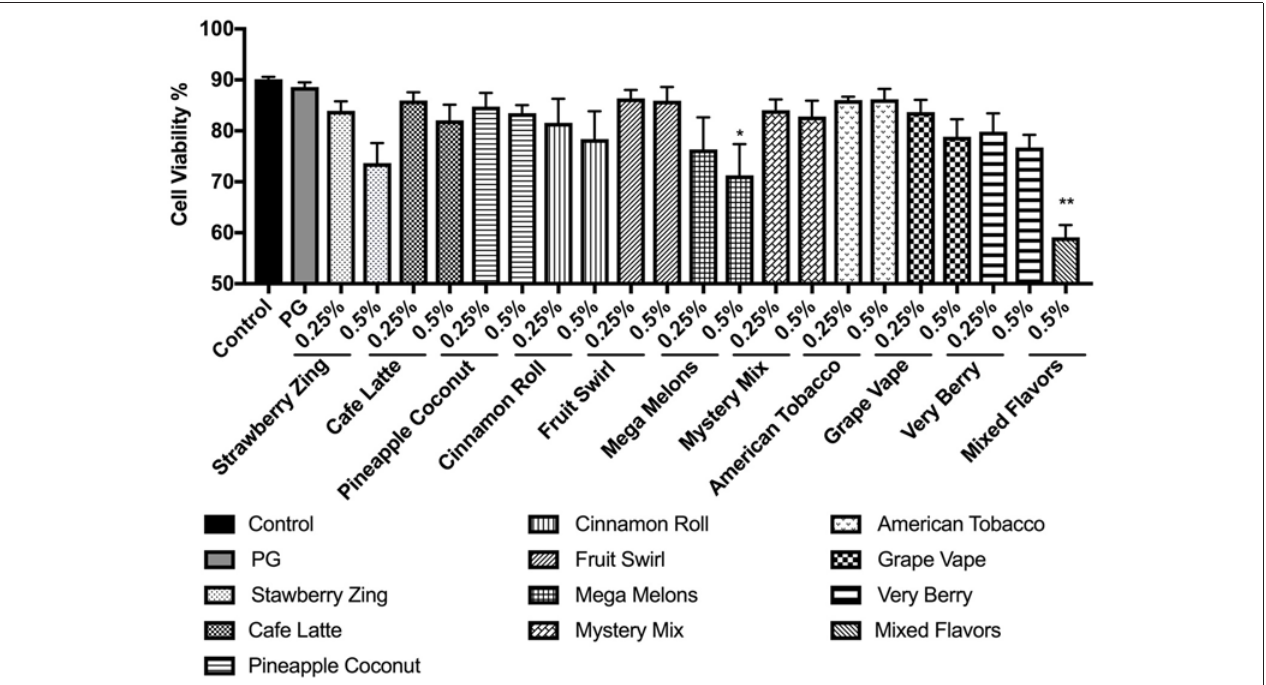
FIGURE 3 | Percent viability of U937 cells 24h post-exposure to e-liquid base propylene glycol and selected nicotine-free e-liquids, i.e., Strawberry Zing, Café Latte, Pineapple Coconut, Cinnamon Roll, Fruit Swirl, Mega Melons, Mystery Mix, American Tobacco, Grape Vape, Very Berry, and mixed flavors at two concentrations 0.25% and 0.5%. U937 monocytes were treated with e-liquids at two concentrations, 0.25% and 0.5% (mixed e-liquid treatment only at 0.5%) for 24h. Cells were then rinsed with PBS and stained with AO/PI. The viability of the cells was assessed using the Cellometer 2000. Data are expressed as mean ± SEM ( n = 5 per treatment group). Statistical significance was determined by one-way ANOVA (Tukey’s multiple comparison test). * p < 0.05, ** p < 0.01 vs.